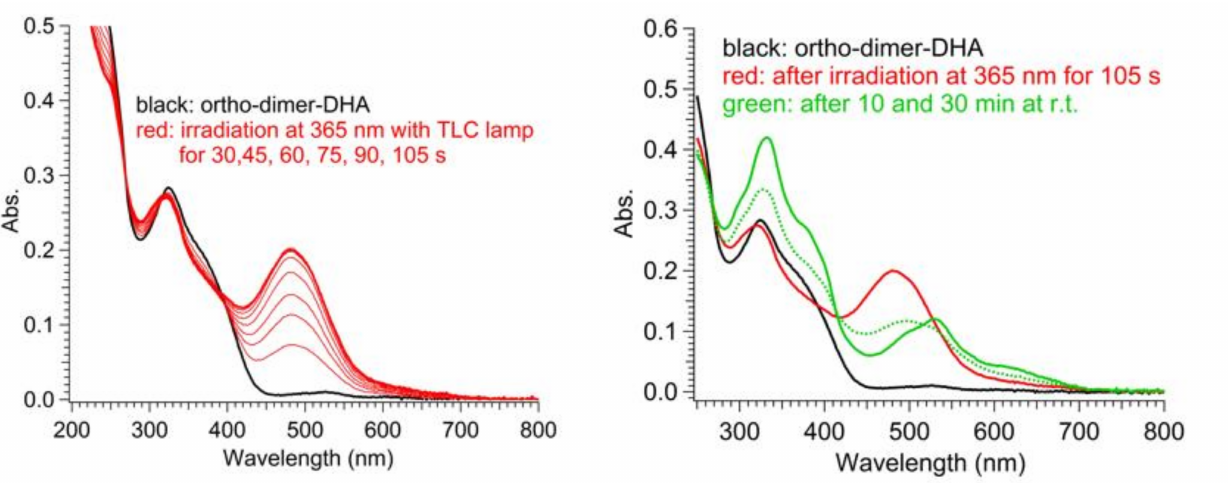
Figure 7. UV-Vis absorption spectra in MeCN of ortho -DHA-dimer 4. Ring opening (left): before (black line) and after irradiation at 365 nm for 30–105 s (red lines). Ring closure (right): before irradiation (black line), after irradiation at 365 nm for 105 s (red line), after thermal relaxation for 10 min (dotted green line) and 30 min (solid green line) at